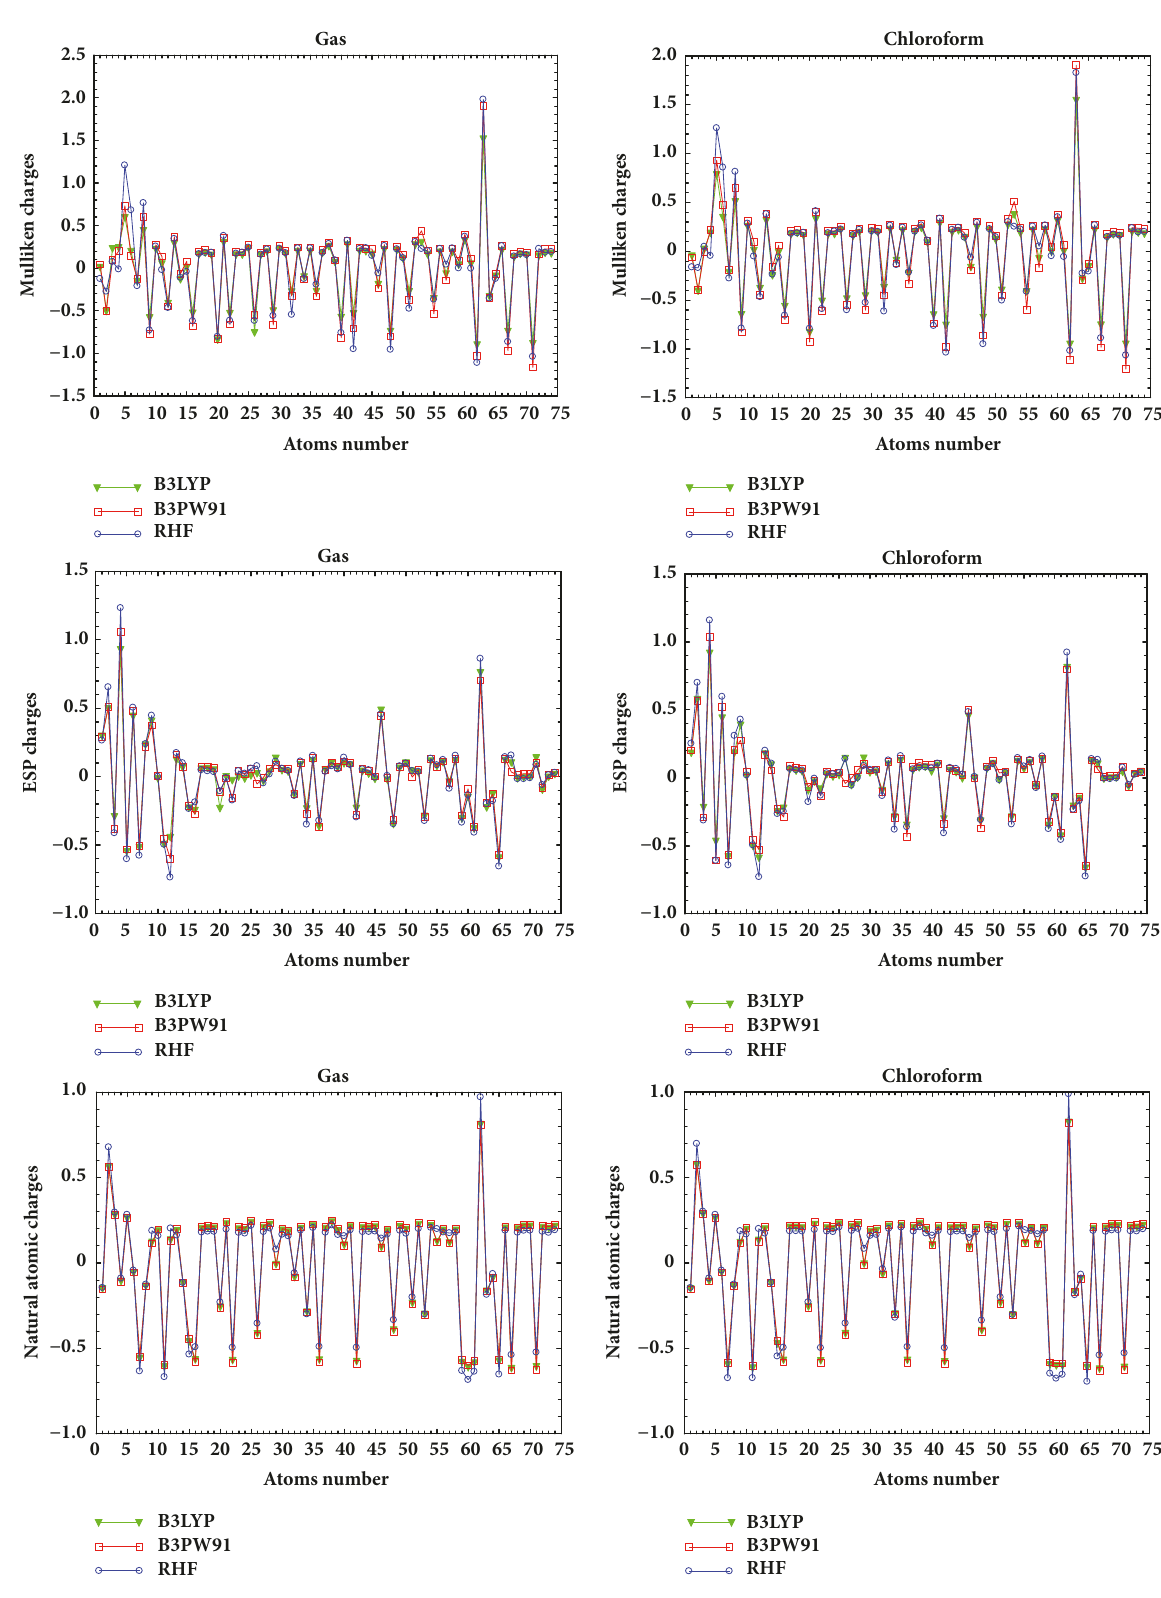
Figure 2: Charge distribution on Rubescin E calculated at the RHF, B3PW91, and B3LYP levels in both gas phase and chloroform solution and with the 6-311++G(d,p) basis